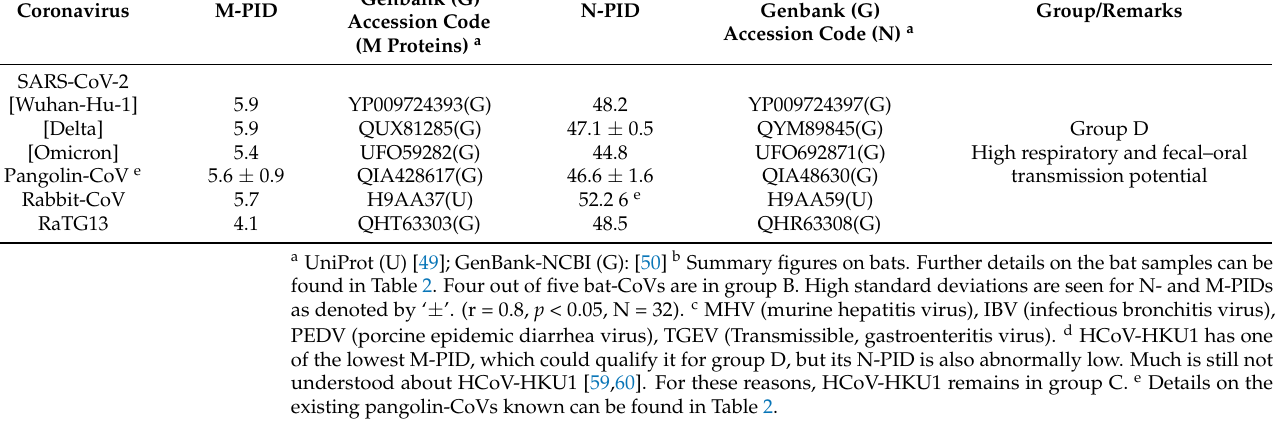
Table 2. Details of the pangolin CoVs and Bat CoVs N/M PIDs and their sequence similarities with the SARS-Co-V and SARS-CoV-2 as references. Using N-PID, SDMs have detected two sub-variants of Delta not previously detected (Delta1,